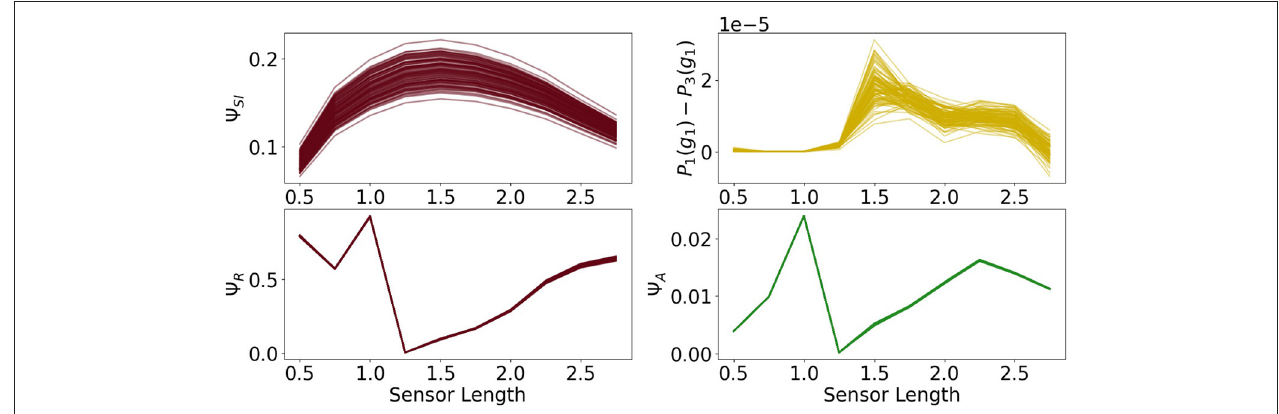
FIGURE 15 | The measures for control morphological computation 9 S , reactive control 9 R and action effect 9 A for the reactive control agents and the performance difference between the fully coupled agents and the reactive